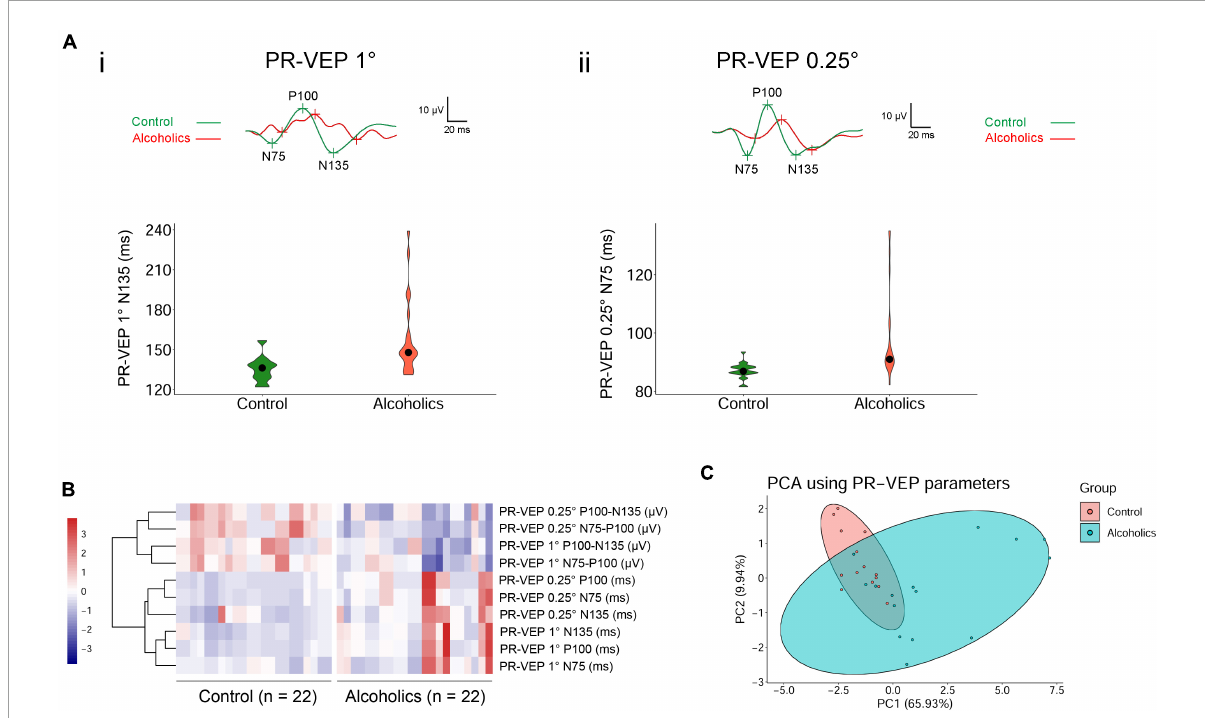
FIGURE2 Pattern-reversal visual evoked potential (PR-VEP) shows significant differences between control individuals and alcoholics. (A) Typical PR-VEP waveforms in normal and alcohol addictive individuals are presented, and quantification of representative parameters are displayed in the form of violin plots. (i) PR-VEP 1 ◦ waveforms and the quantification and distribution of N135 peak times are shown. (ii) PR-VEP 0.25 ◦ waveforms and the quantification and distribution of N75 peak times are shown. (B) Heatmap reveals that all amplitudes are reduced and most peak times are prolonged in alcohol addicts by PR-VEP measurements. Correlated parameters are clustered. (C) PCA combining data from PR-VEP parameters shows variation between the normal and alcoholics across PC1 and